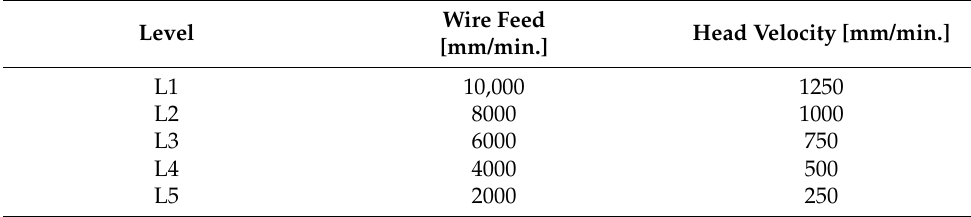
Table 3. Values for wire feed and welding head velocity selected for both kinds of materials.